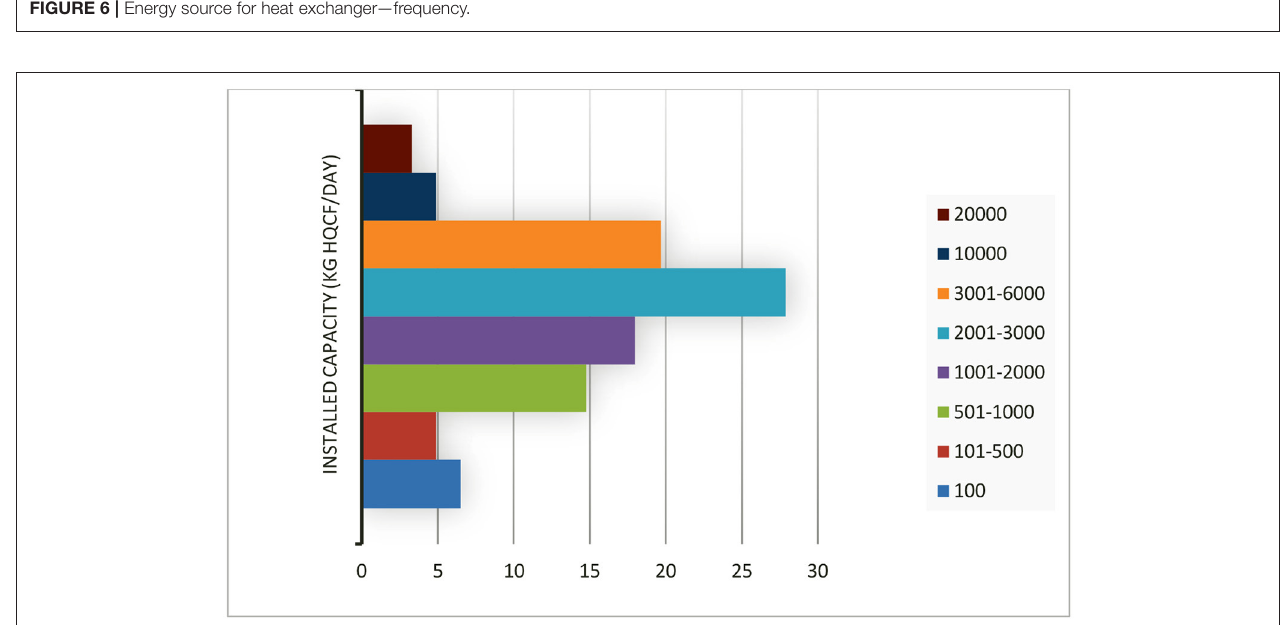
FIGURE 6 | Energy source for heat exchanger—frequency.